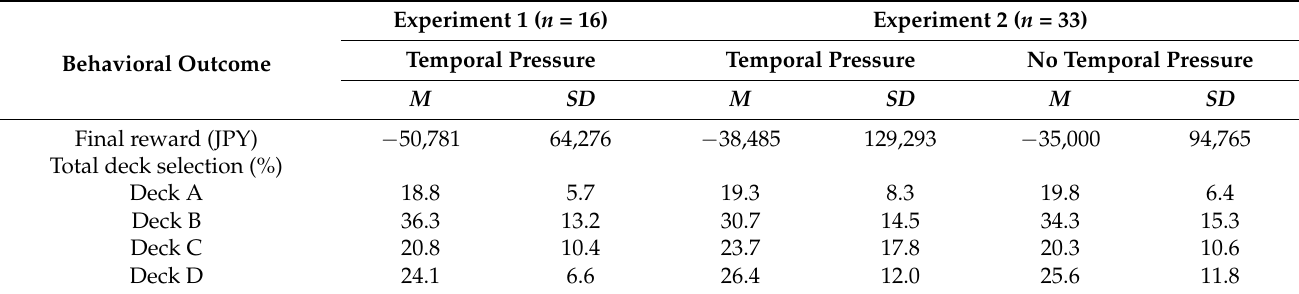
Table 1. Behavioral results of the IGT in Experiments 1 and